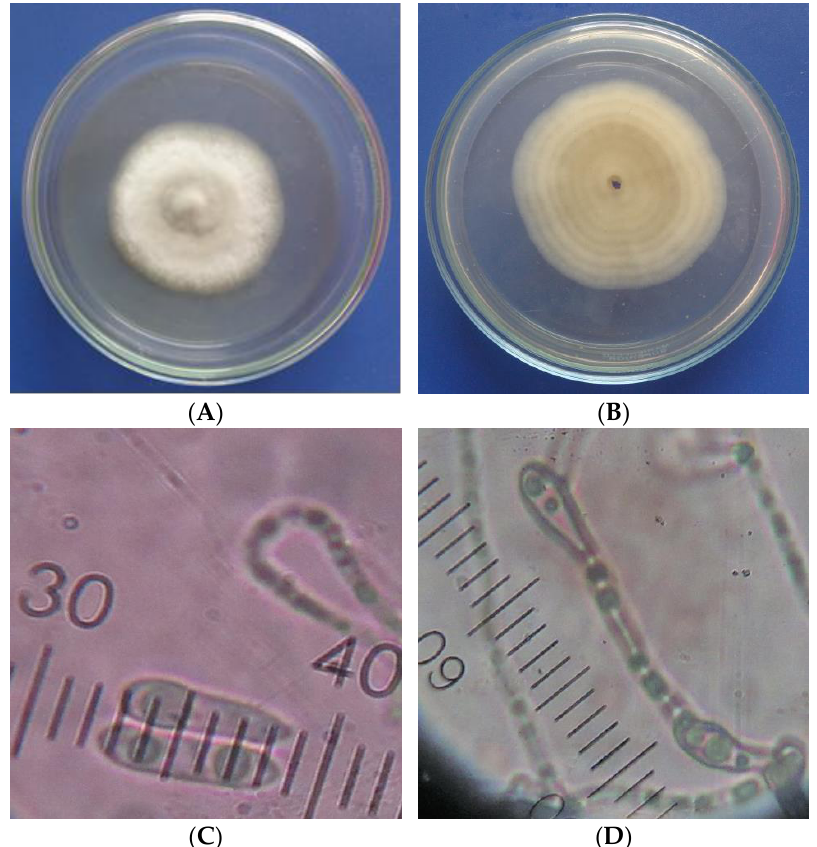
Figure 2. The cultural and morphological characteristics of Colletotrichum sp. causing anthracnose on Cat Hoa Loc mango fruits at 9 days after inoculation. ( A ) Upper colony surface, ( B ) lower colony surface, ( C ) conidia, ( D ) conidiophores.